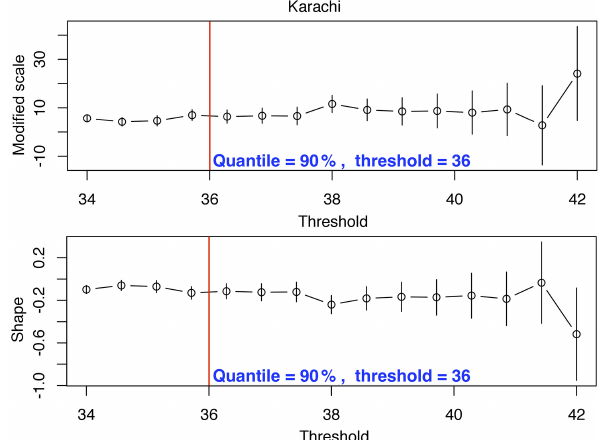
Figure 2. Modified scale ( σ ∗ ) and shape parameter ( ξ ) of the ob- served T max ( ◦ C) at Karachi. The red vertical lines represent the selected threshold according to the station